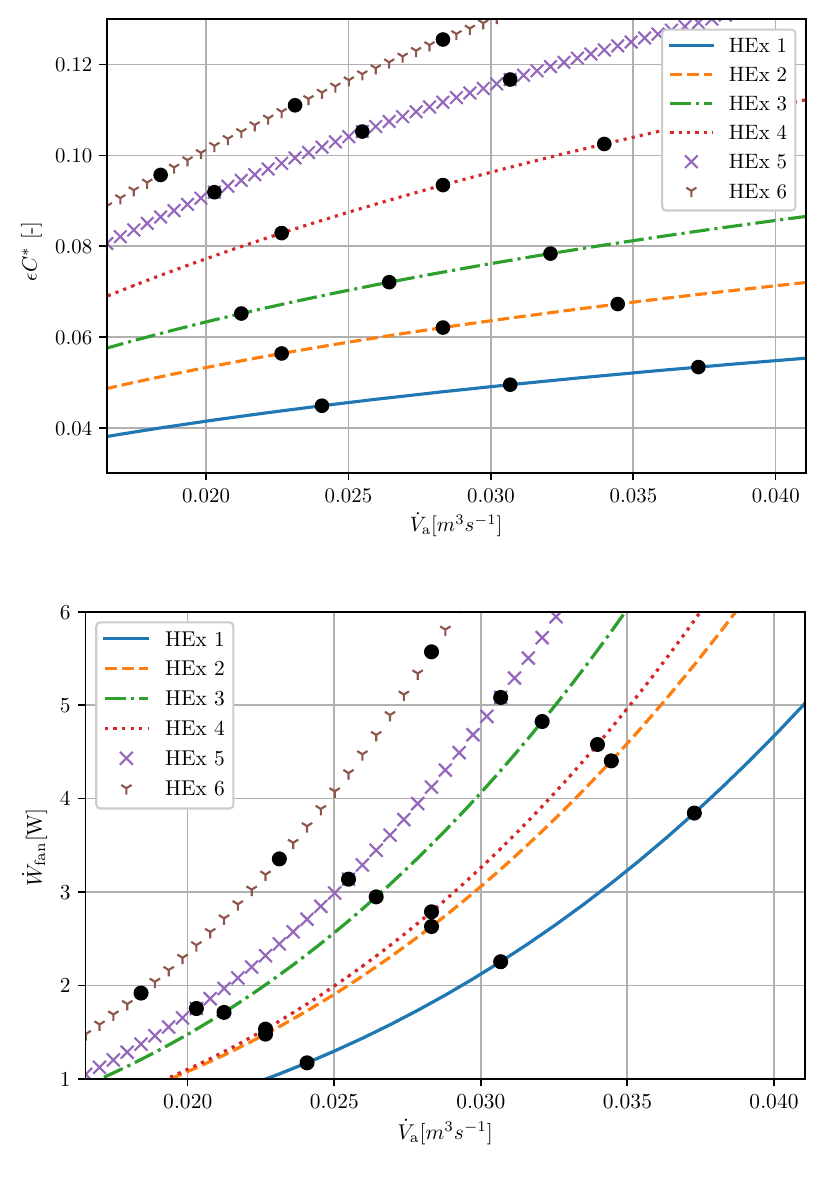
Figure 9. Effect of the heat exchanger geometry and operating conditions on the fan power consumption. The three markers along each curve correspond to the operating points of the heat exchanger/fan